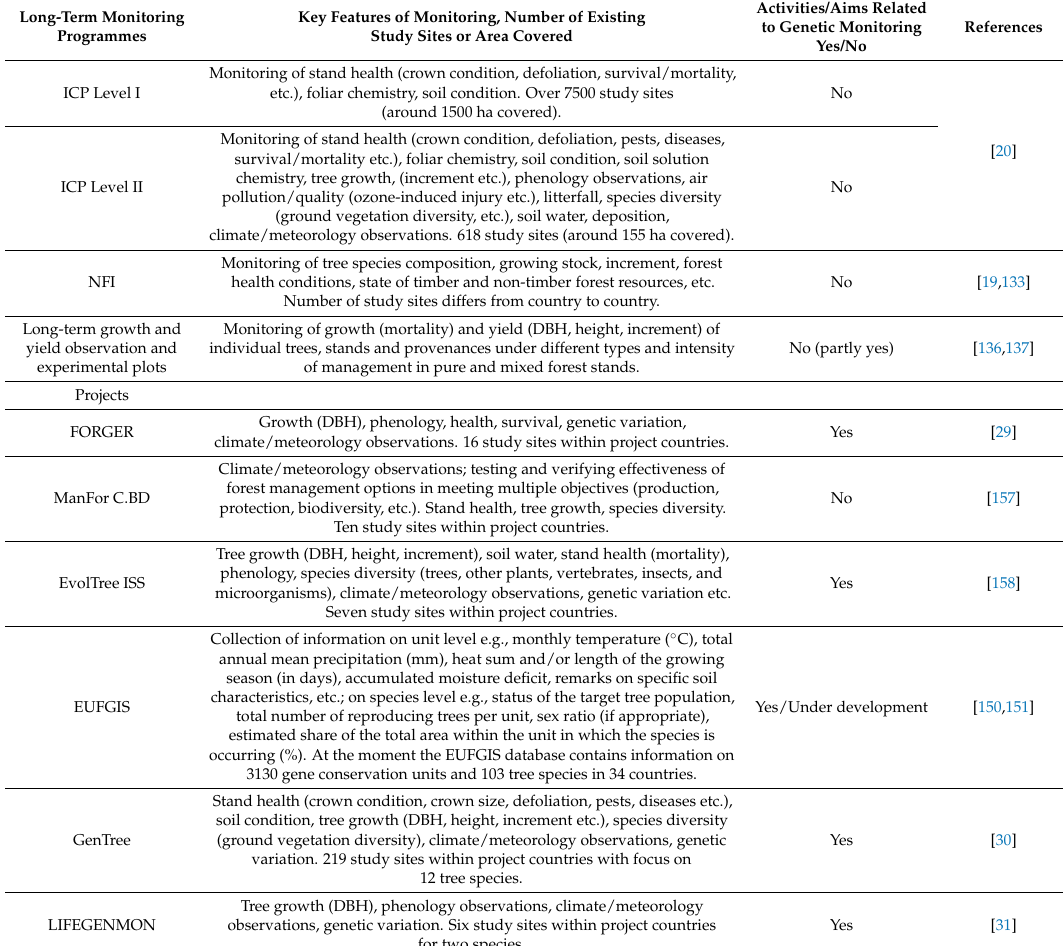
Table 4. Overview of long-term monitoring programmes and research projects. Key Features of Monitoring, Number of Existing Study Sites or Area